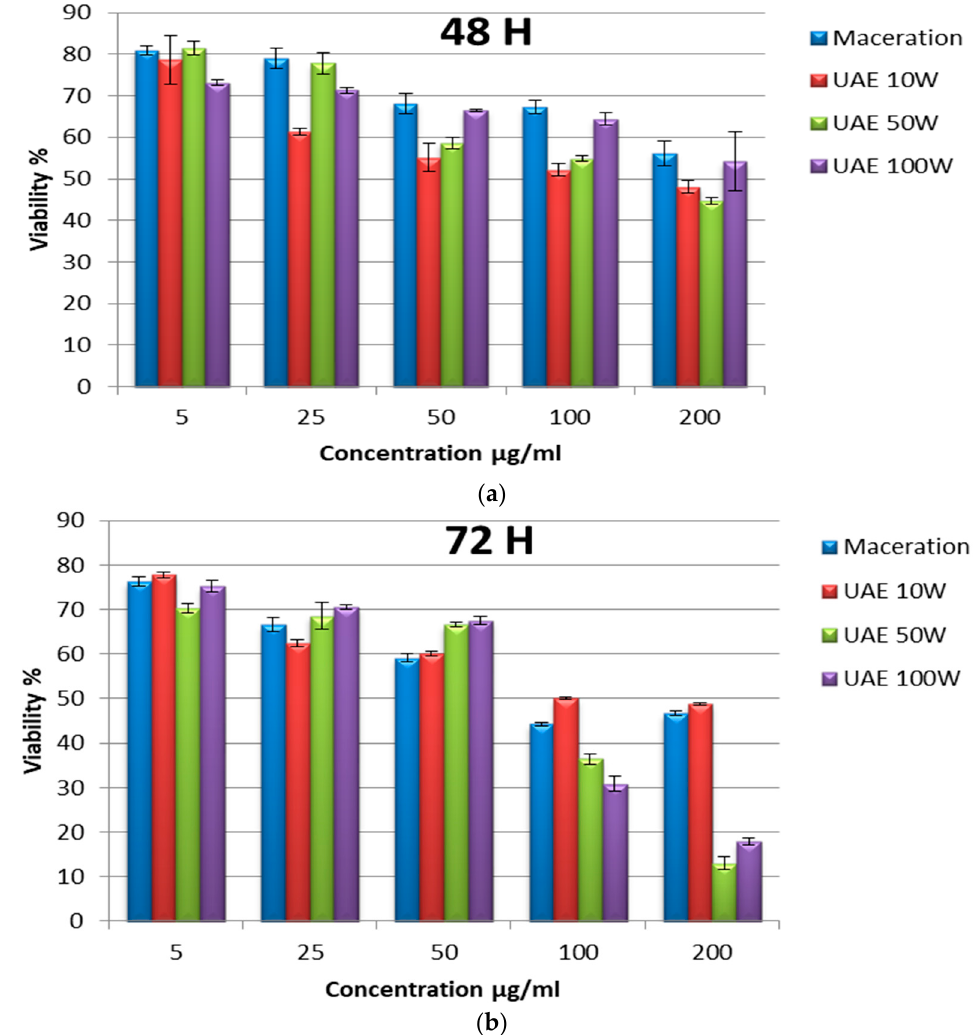
Figure 5. Proliferation rate of HCT-116 colorectal cells treated with different concentrations of ethanolic extracts of pomegranate peels by maceration and ultrasound (10 W; 50 W; and 100 W) at 48 h ( a ) and 72 h ( b ). Experiments were repeated three times ( n = 3). Bars display mean ± S.D. Ultrasound assisted extraction at the power of 10 W exerted a slightly higher antipro- liferative effect compared to the maceration extract at 48 h of treatment, with a cell viablity equal to 78.63% and 48.06% that of the control cells at 5 µ g/mL and 200 µ g/mL of extract, respectively. However, no significant difference was observed at 72 h of